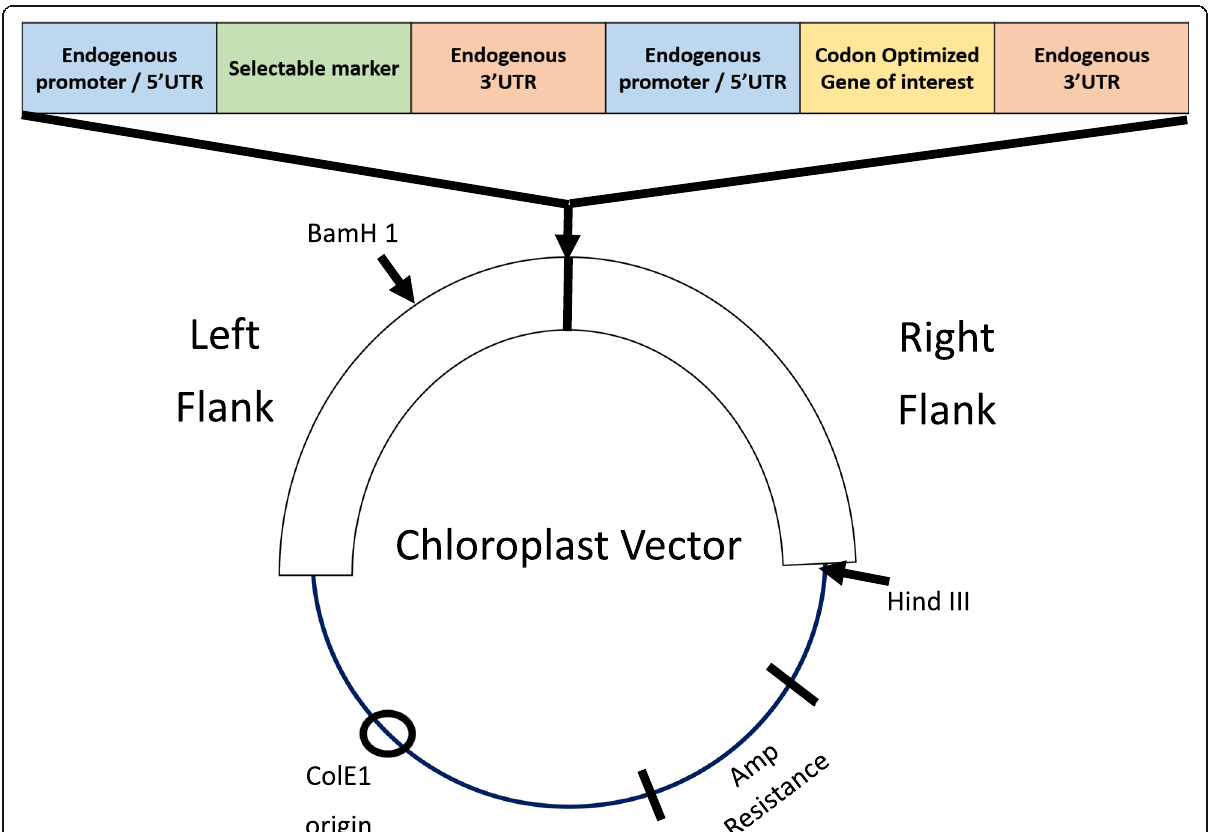
Fig. 1 The design of a common chloroplast